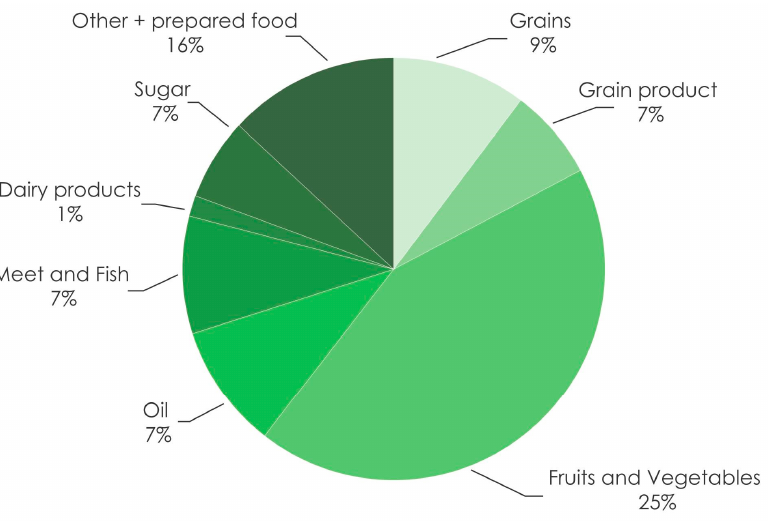
Figure 2. Canada’s food miles related to CO 2 emissions by specific food group